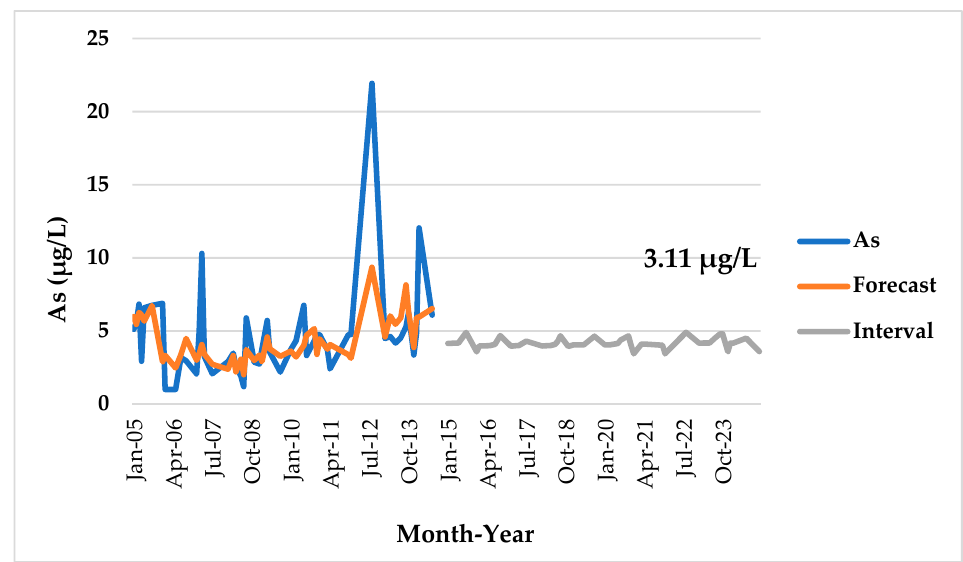
Figure 5. Forecast of As ( μ g/L) concentration in the Langat River based on the GBT model from January 2005 to December 2024.